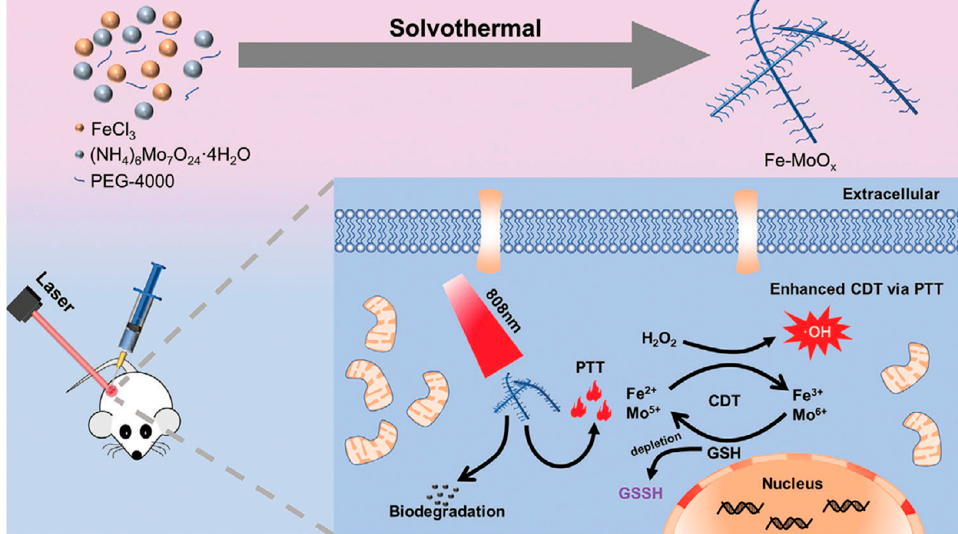
Figure 2. Schematic depicting the synthesis of FMO nanowires and demonstrating FMO for photo- thermal enhanced CDT and GSH-depleted amplified CDT. Reprinted with permission from Ref. [61]. Copyright 2021, Wiley-VCH Verlag GmbH & Co. KGaA,